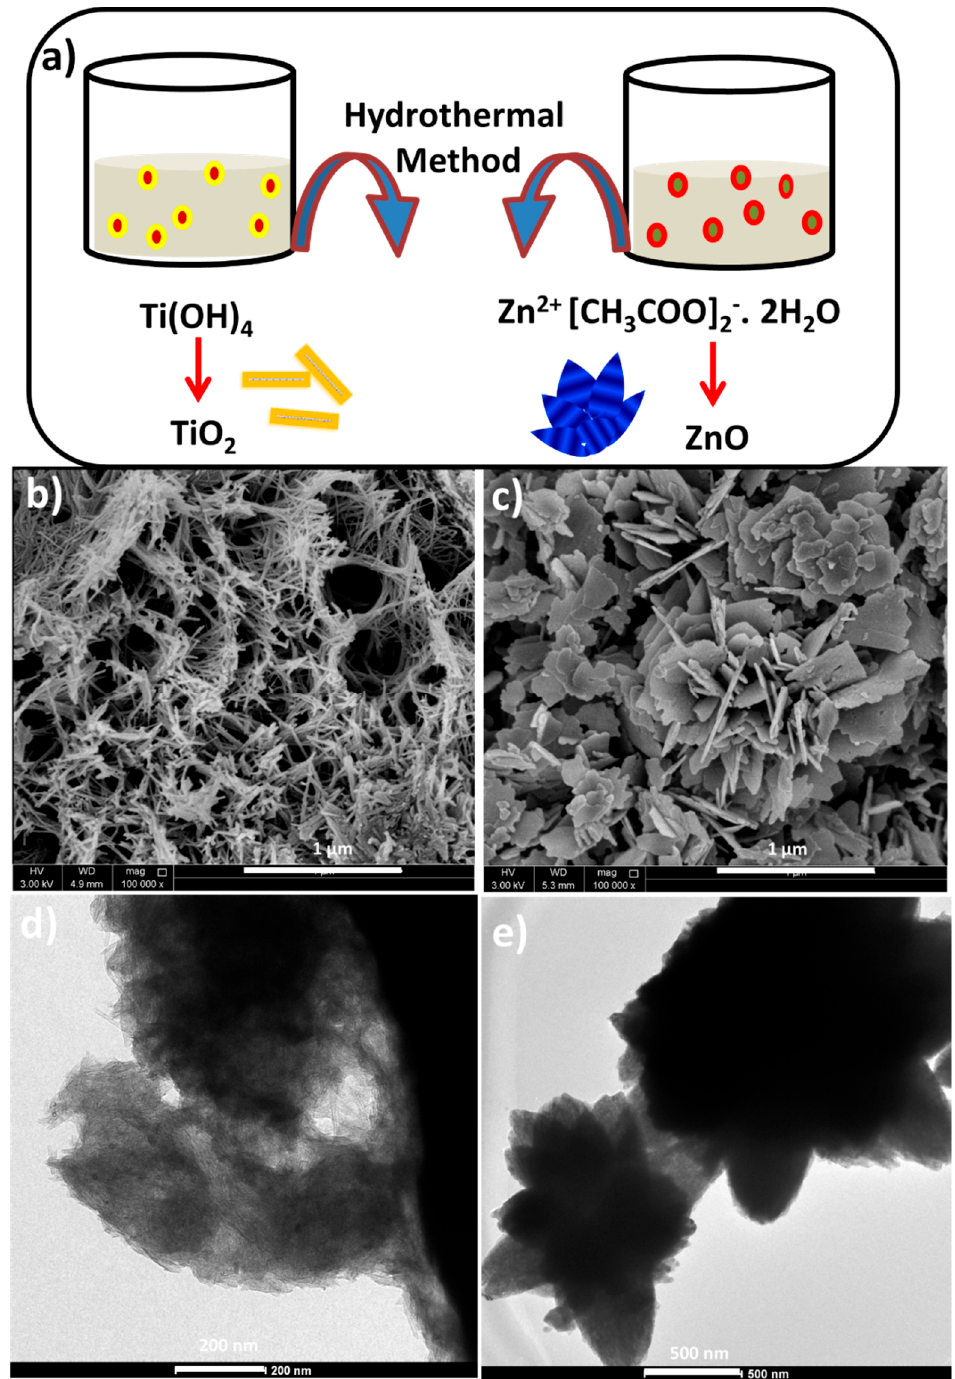
Figure 2. ( a ) Schematic representation of TiO 2 and ZnO preparation. SEM images of ( b ) TiO 2 and ( c ) ZnO. TEM images of ( d ) TiO 2 and ( e ) ZnO.